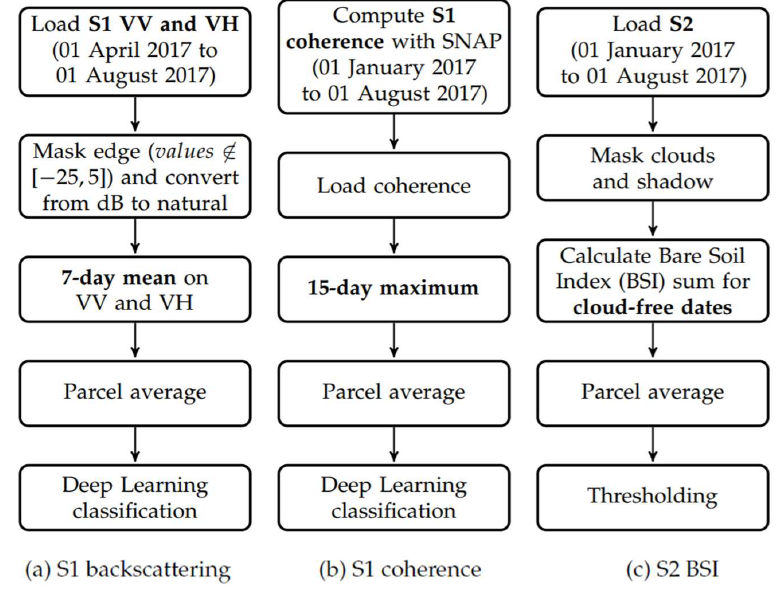
Figure 2. Main processing steps for S1 backscattering ( a ), S1 coherence ( b ) and S2 BSI ( c